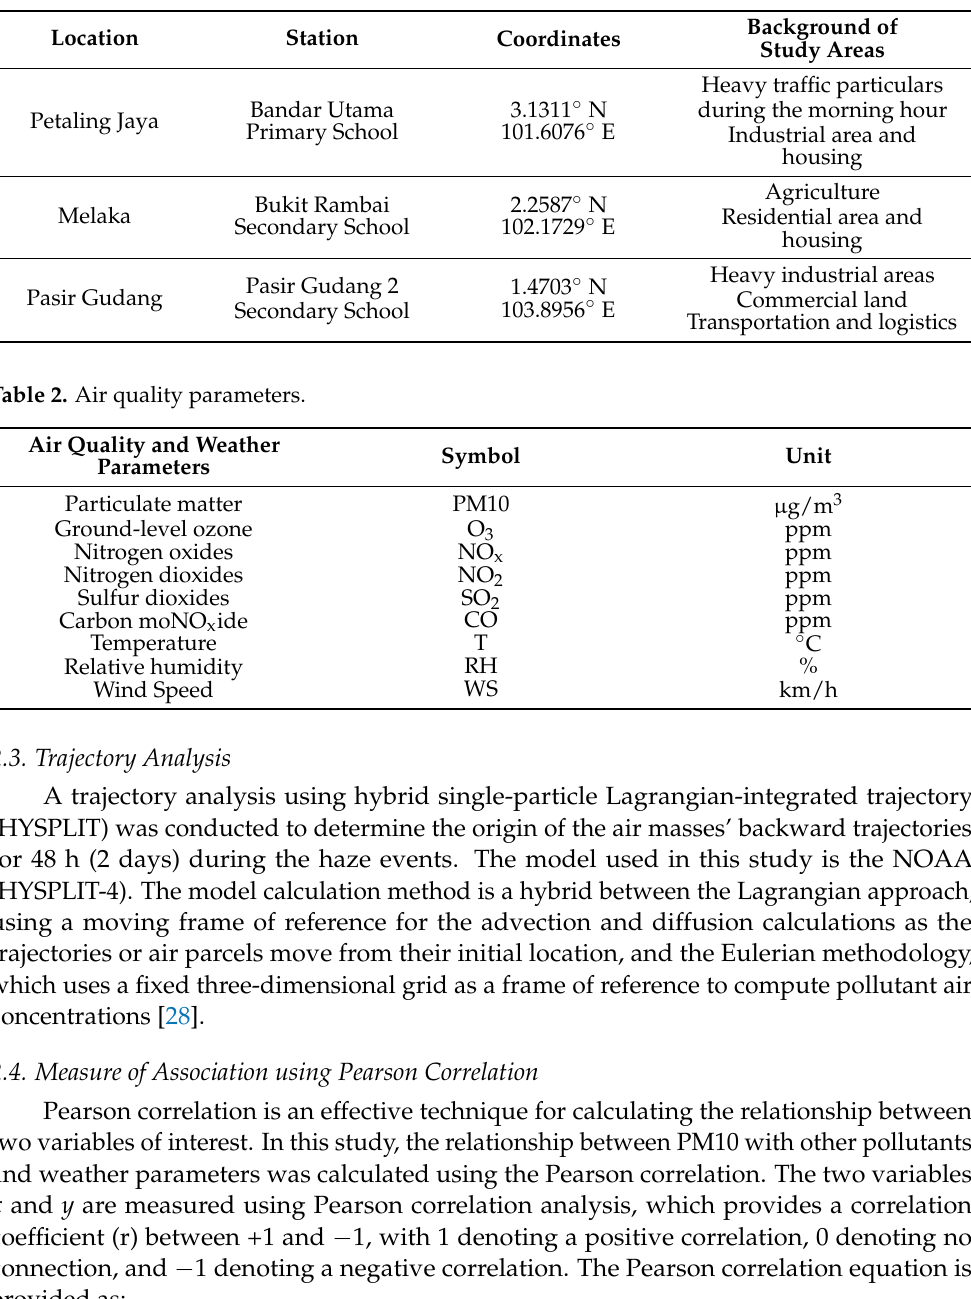
Table 1. Details of study areas.